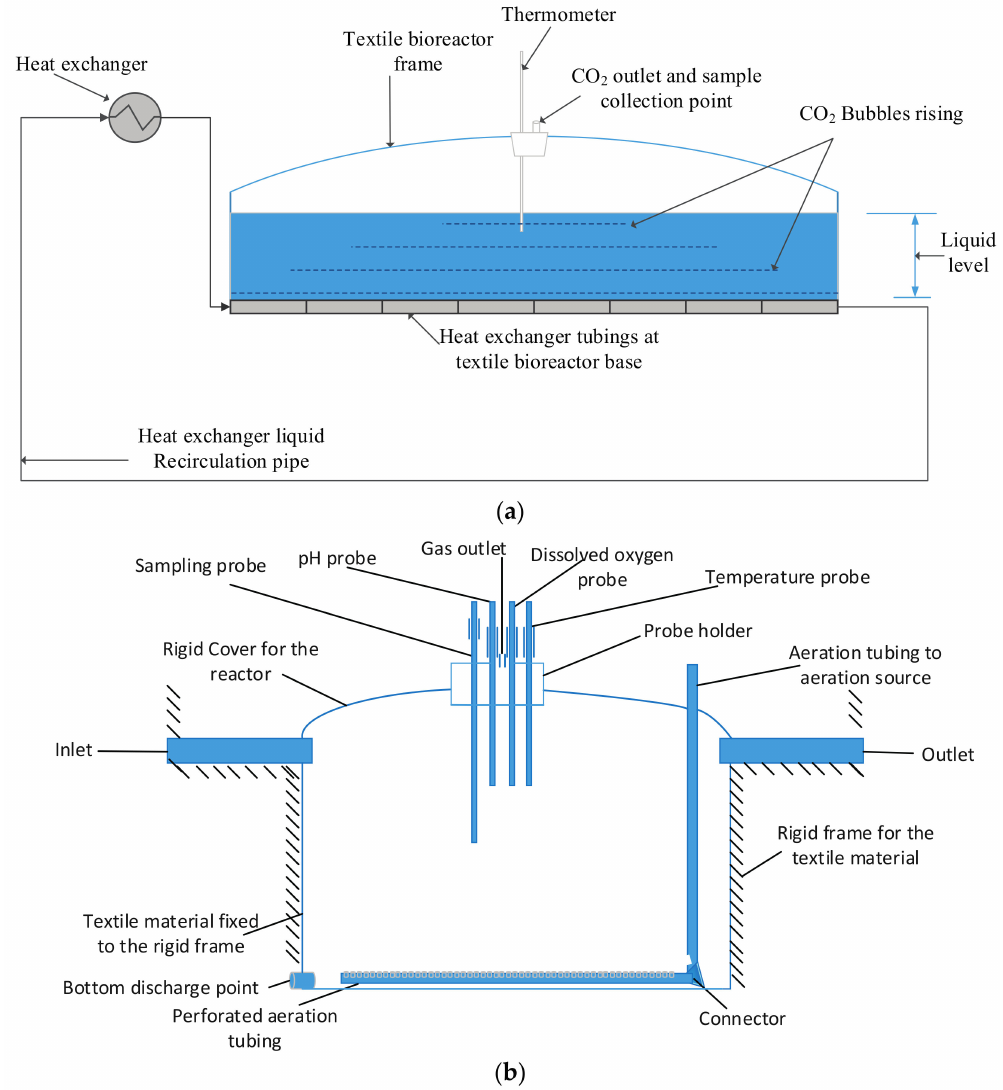
Figure 1. ( a ) Schematic of the laboratory scale prototype of the all-polyamide composite-coated-fabric (APCCF) bioreactor; ( b ) General schematic representation of APCCF